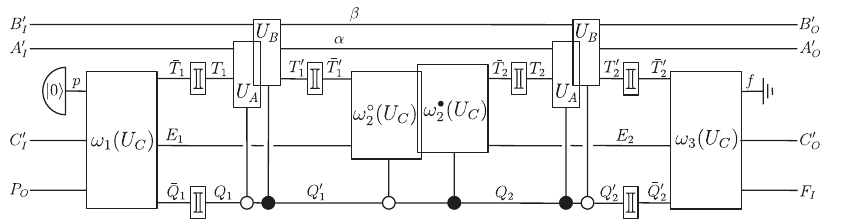
Fig. 3 | Temporal circuit for a general tripartite unitary process. U A and U B are appliedeitheronthetime-localtargetsystem T ð0Þ 1 or T ð0Þ 2 (andtheancillarysystems), dependingcoherentlyonthestateofthetwo-dimensionalcontrolsystems Q ð0Þ 1 and Q ð0Þ 2 . These two applications of the coherently controlled operations surrounded by circuit operations ω 1 ð U C Þ : H pC 0 I P O ! H (cid:2) T 1 E 1 (cid:2) Q 1 , ω (cid:7) 2 ð U C Þ : H (cid:2) T 0 1 E 1 ! H (cid:2) T 2 E 2 , ω (cid:8) ð U C Þ : H (cid:2) T 0 1 E 1 ! H (cid:2) T 2 E 2 (these two also being coherently controlled), and 2 U C Þ : H (cid:2) T 0 2 E 2 (cid:2) Q 0 2 ! H fC 0 O F I , which can (together with the therein introduced ω 3 ð ancillary systems E 1 , E 2 ) in general all depend on U C , the third party ’ s (Charlie ’ s) operation. The boxes I stand for identity channels thatrelate the systems withand without the bars. The ancillary system p is prepared in the state ∣ 0 i p in